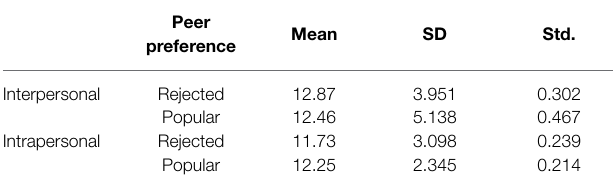
TABLE 3 | Perception of the school environment in rejected and popular